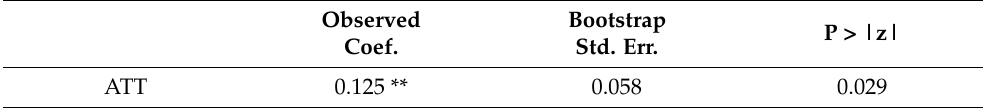
Table 4. Results of the PSM test.